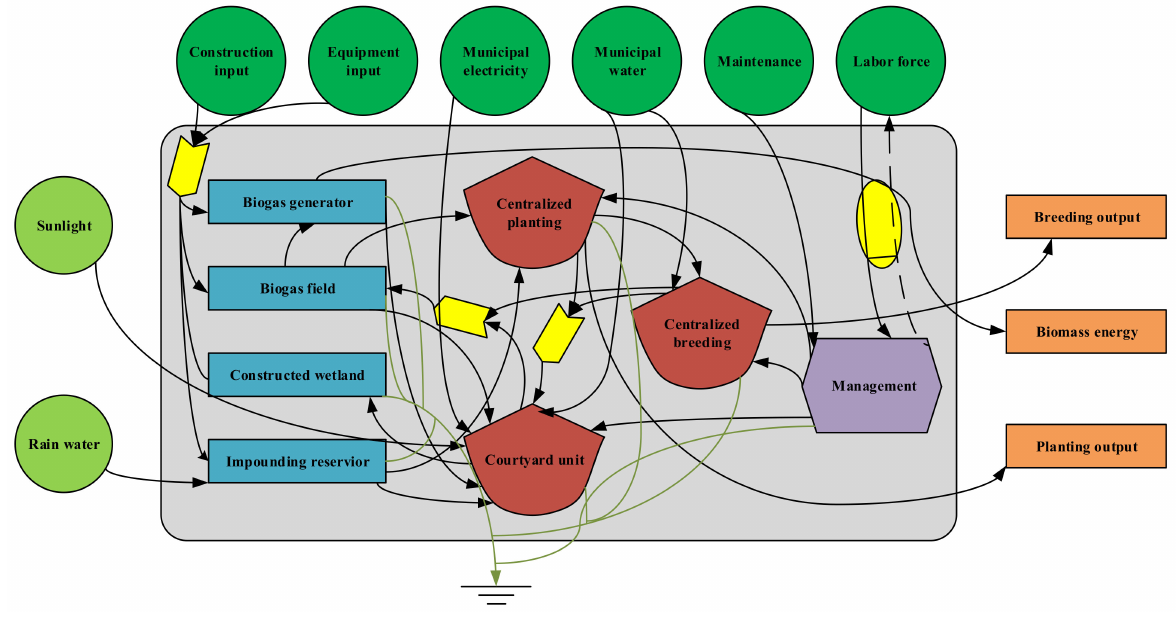
Figure 4. Energetic flow diagram of the cluster